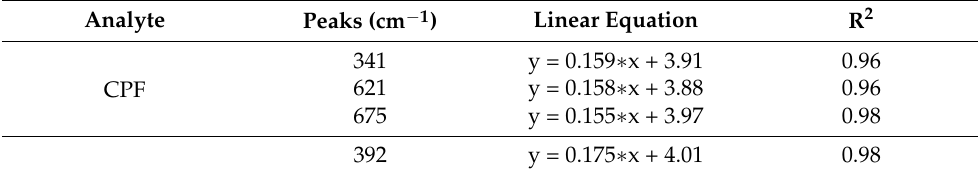
Table 3. Linear relationship between concentrations of CPF and 2,4-D on apple surfaces and Ra-man intensities.